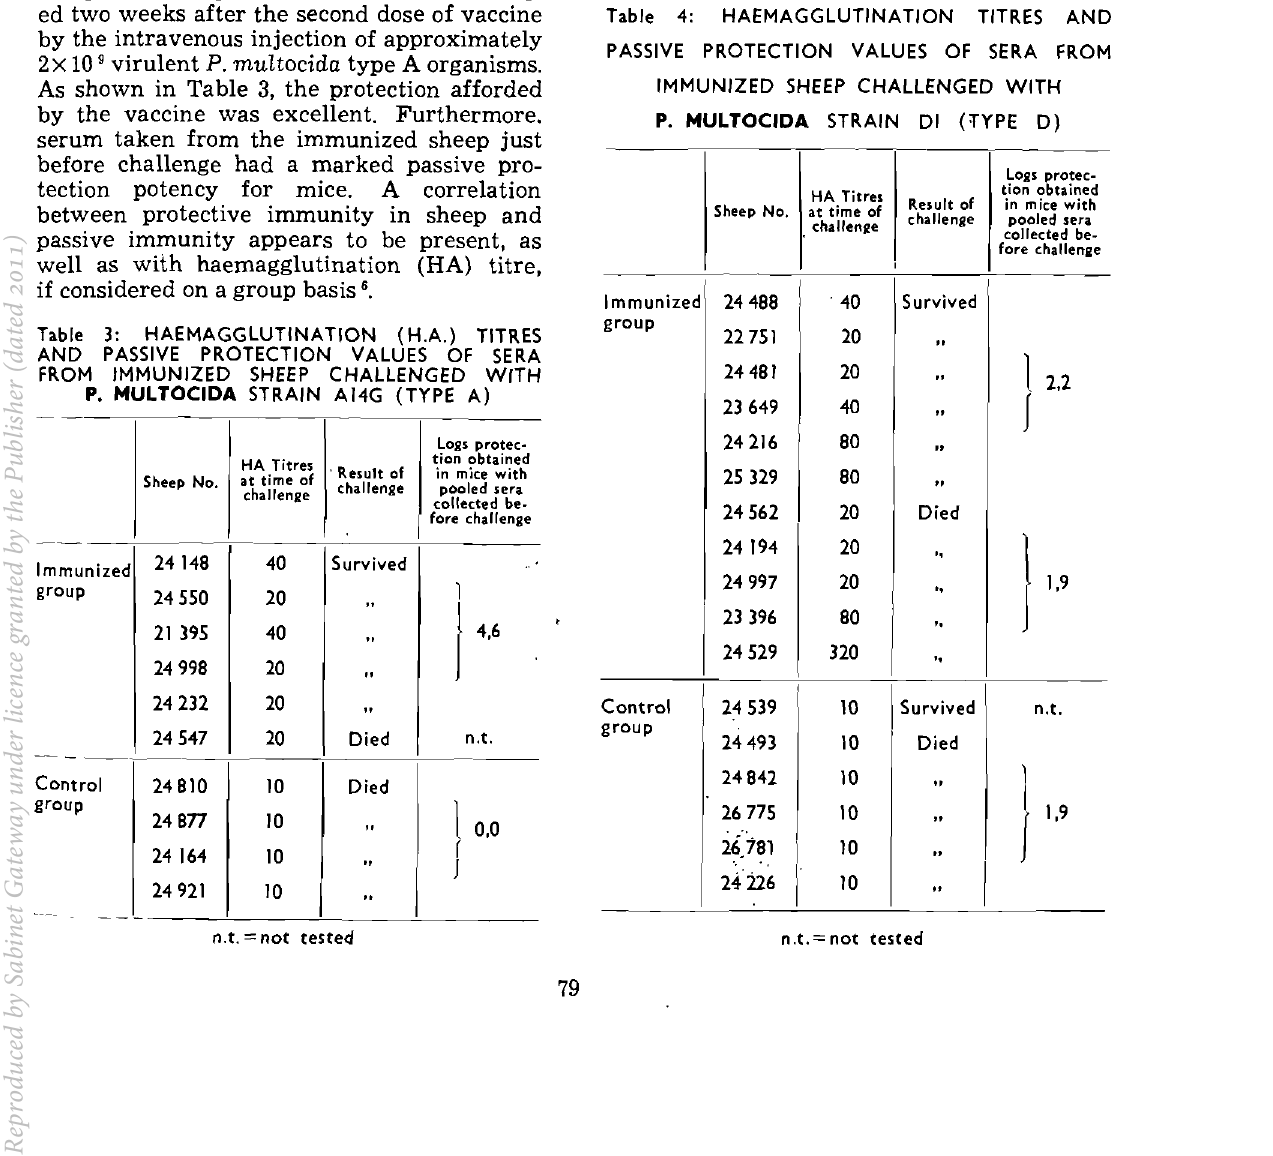
HAEMAGGLUTINATION TIT RES AND PASSIVE PROTECTION VALUES OF SERA